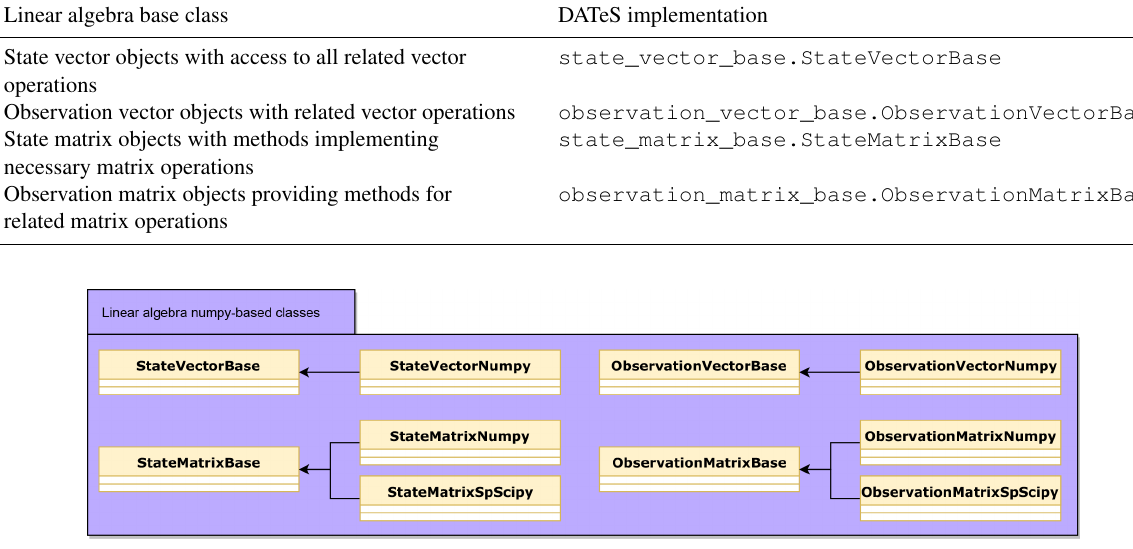
Figure 2. Python implementation of state vector, observation vector, state matrix, and observation matrix data structures. Both dense and sparse state and observation matrices are